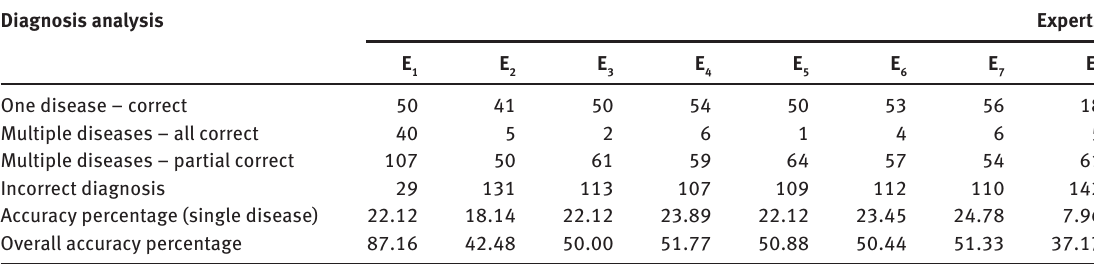
Table 7: Diagnosis Analysis for Eight Experts (Eight Experts, 226 Patients). Diagnosis